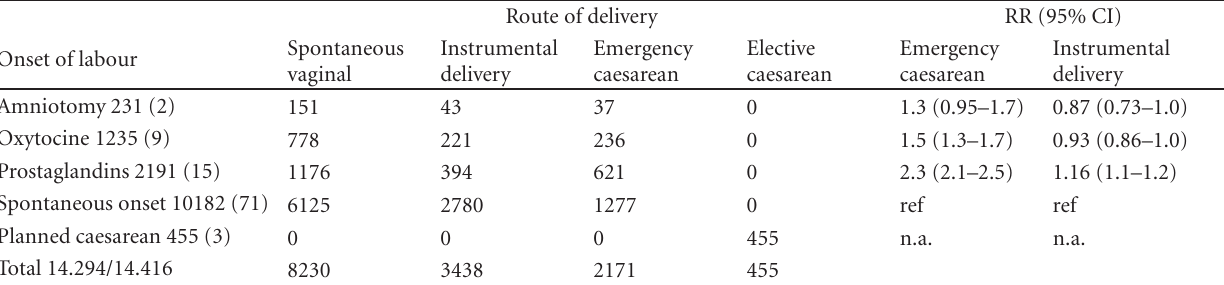
Table 1: Process of labour in pregnancies complicated by SGA.